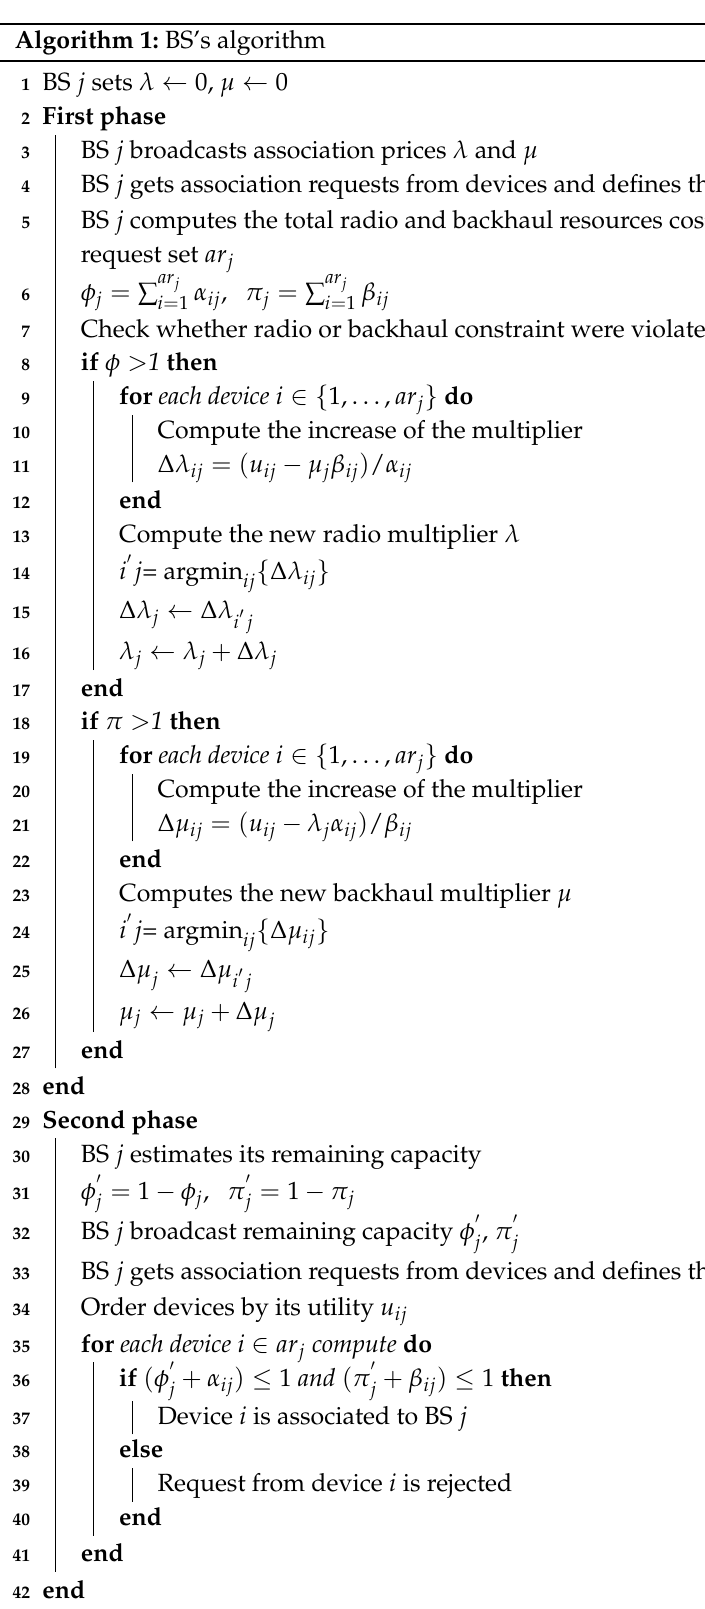
Algorithm 1: BS’s